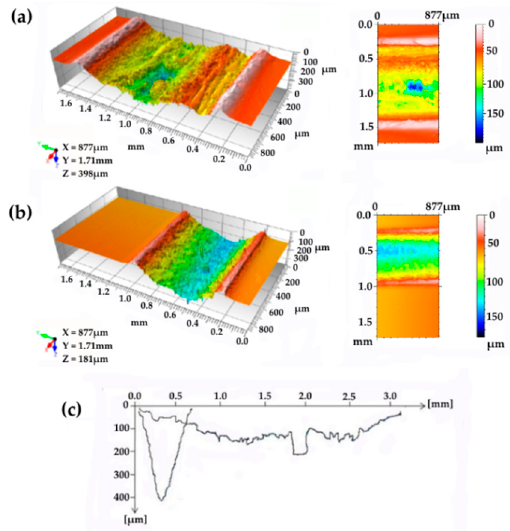
Figure 4. Profilometric measurements of tracks processed on polycarbonate and acrylonitrile– butadiene–styrene blend (PC-ABS)/0.5 wt.% CNT composite under different conditions: ( a ) wide and deep track resulting from repetitions (D = 0, P = 10, F = 5, S = 100, N = 20), ( b ) less severe treatment (D = 50, P = 50, F = 5, S = 600, N = 1), ( c ) comparison between narrow and deep track profile, obtained on PP/2 wt.% CNTs, resulting from low defocusing (D = 50, P = 15, F = 15, S = 200, N = 25) and wide track profile (D = 150, P = 40, F = 15, S = 200, N =